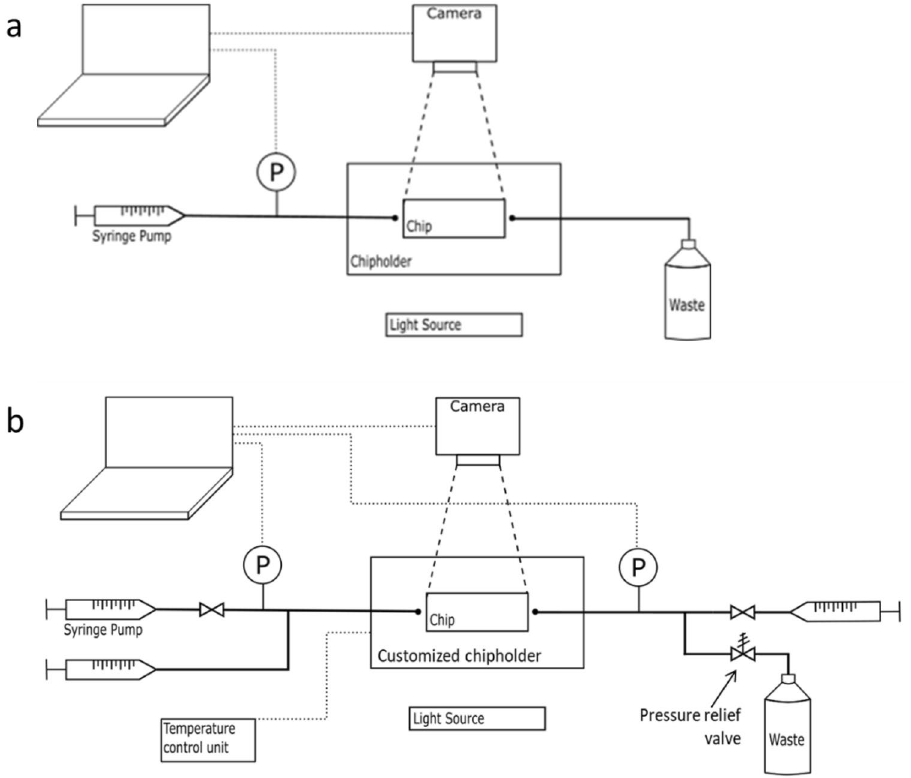
Figure 8. Schematic illustration of the microfluidic setup for tests at ambient conditions ( a ) and at elevated temperatures and pressures ( b ). The dimensions shown are not to scale 21 .